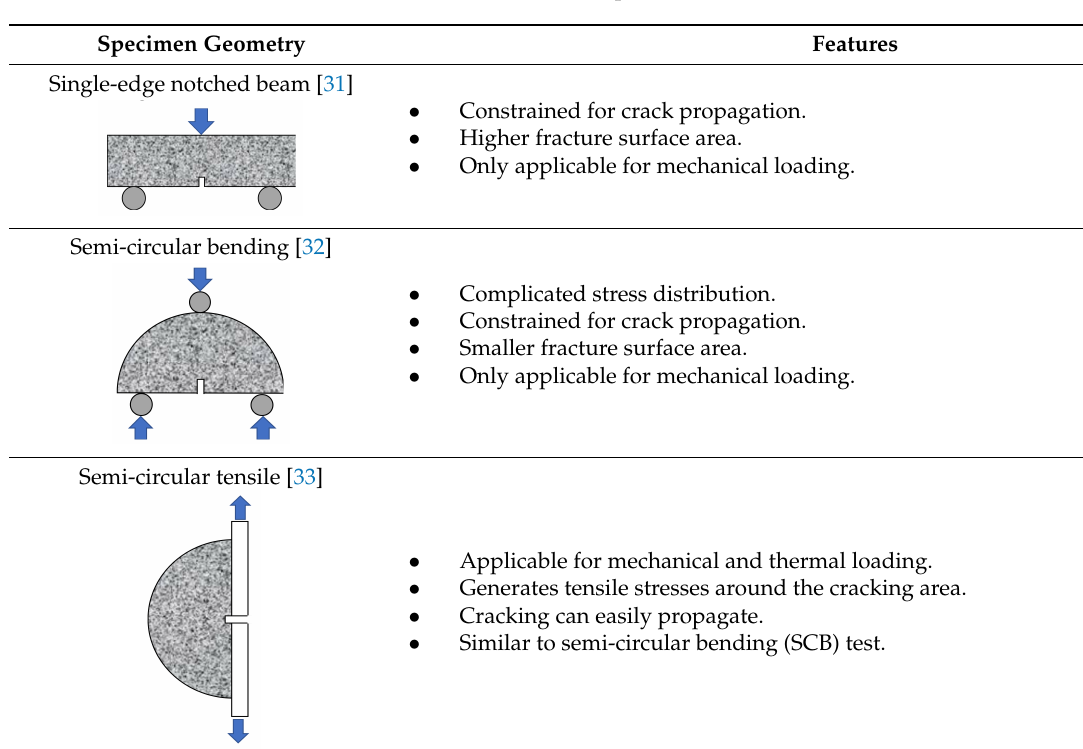
Table 2. Specimen geometries and features of common notched asphalt mixture fracture test configu- rations (test on notched